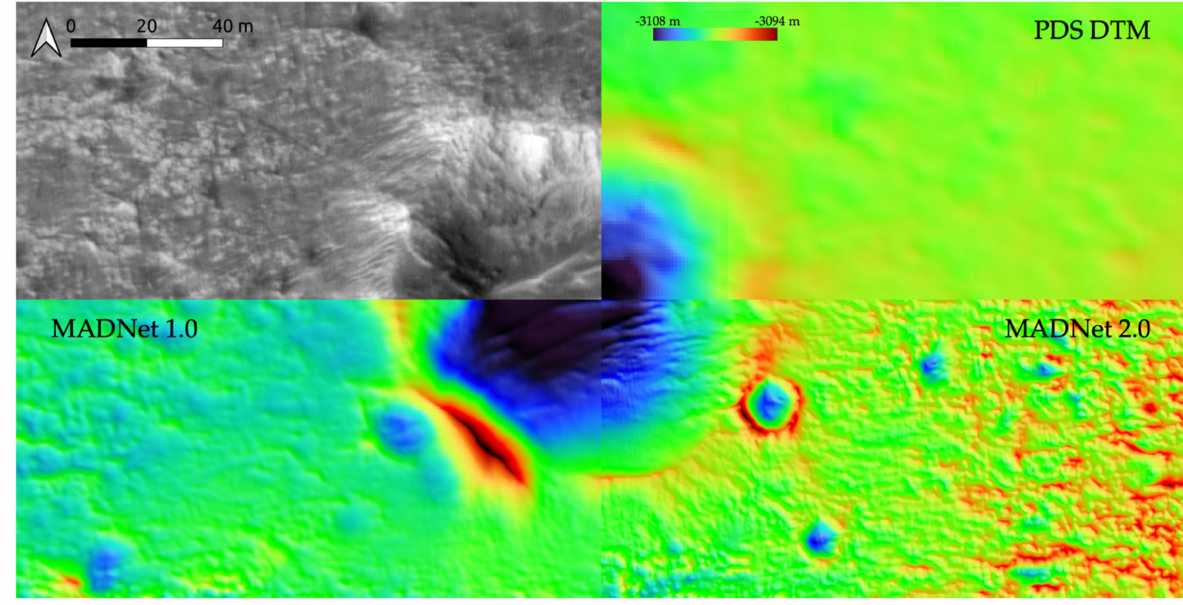
Figure 2. A side-by-side view example of the 25 cm/pixel HiRISE (ESP_003195_1985_RED) image, 1 m/pixel PDS DTM, 50 cm/pixel MADNet 1.0 DTM (from [7]), and the resultant 25 cm/pixel MADNet 2.0 DTM (colourised and